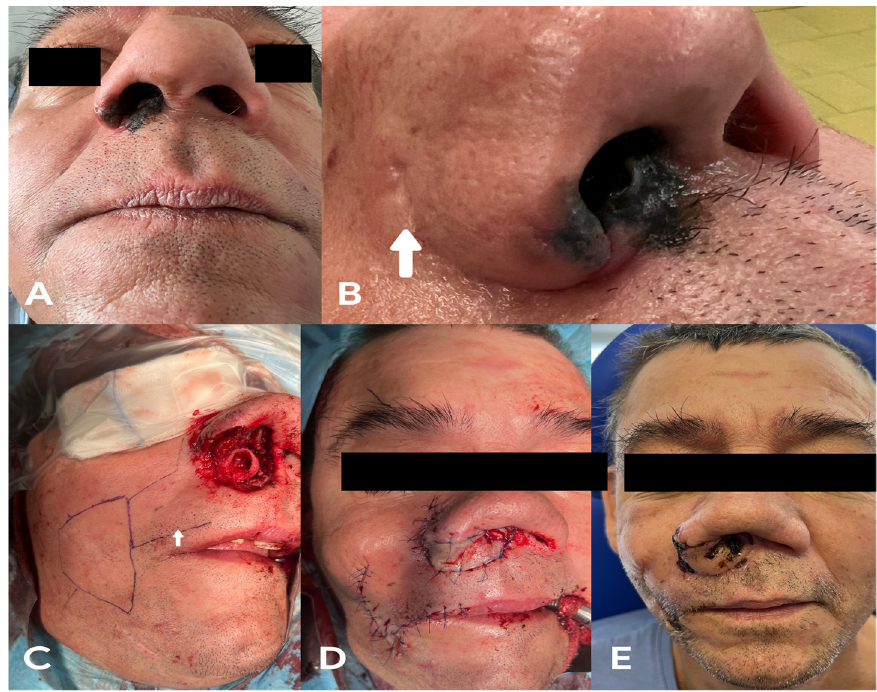
Figure 5. ( A ) melanoma of the right vestibulum and nasal cavity, ( B ) scar left by previous surgery (white arrow), ( C ) rSLA flap planning, ( D ) final reconstruction, and ( E ) patient one month after the surgery.